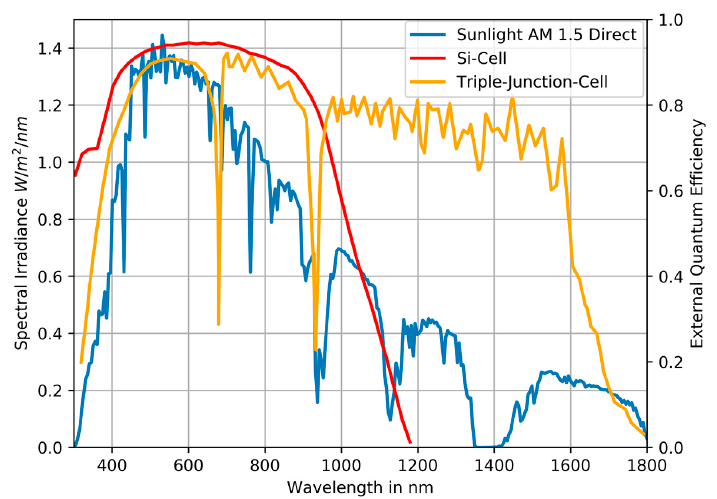
silicon-based cell and of a multi-junction solar cell. Data based on